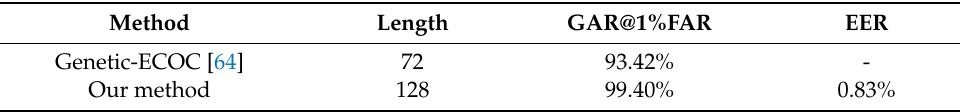
Table 2. Accuracy comparison on Extended YaleB dataset.